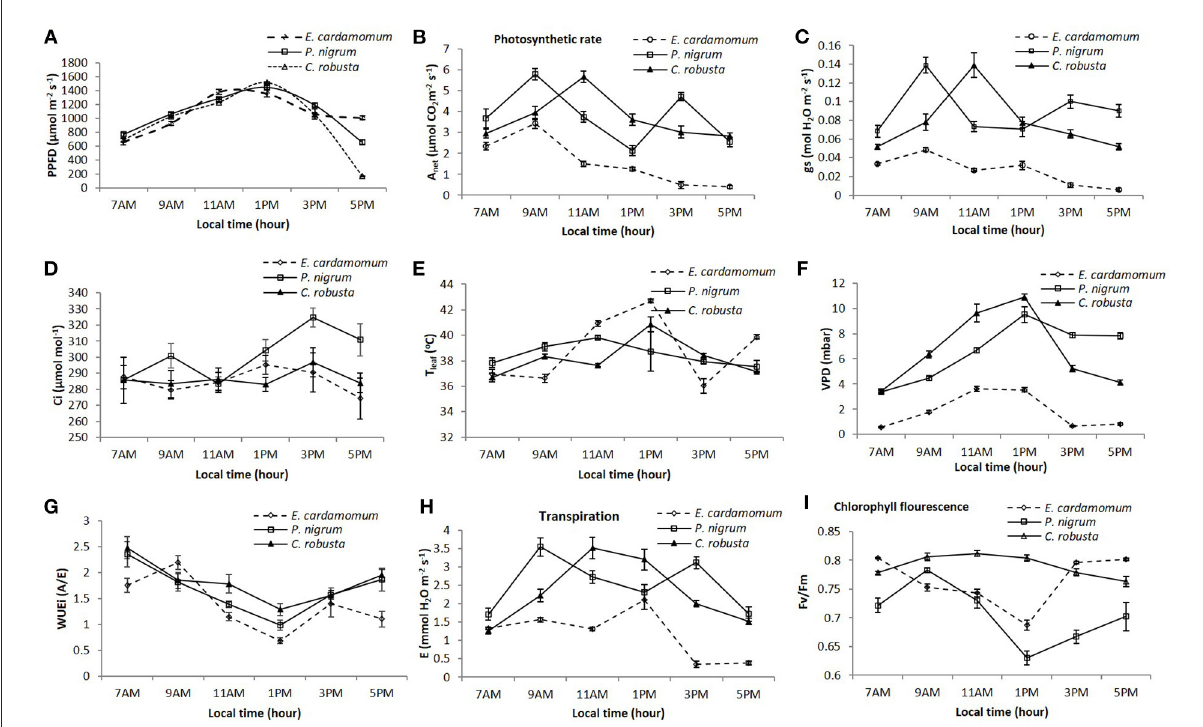
FIGURE6 Eco-physiological parameters of cardamom, black pepper, and coffee. (A) Photosynthetic photon flux density (PPFD). (B) Net photosynthetic rate (Anet). (C) Stomatal conductance (gs). (D) Internal CO 2 concentration (Ci). (E) Leaf temperature (Tleaf). (F) Vapor pressure deficit (VPD). (G) Intrinsic water use efficiency (WUEi). (H) Transpiration rate (E) . (I) Chlorophyll fluorescence